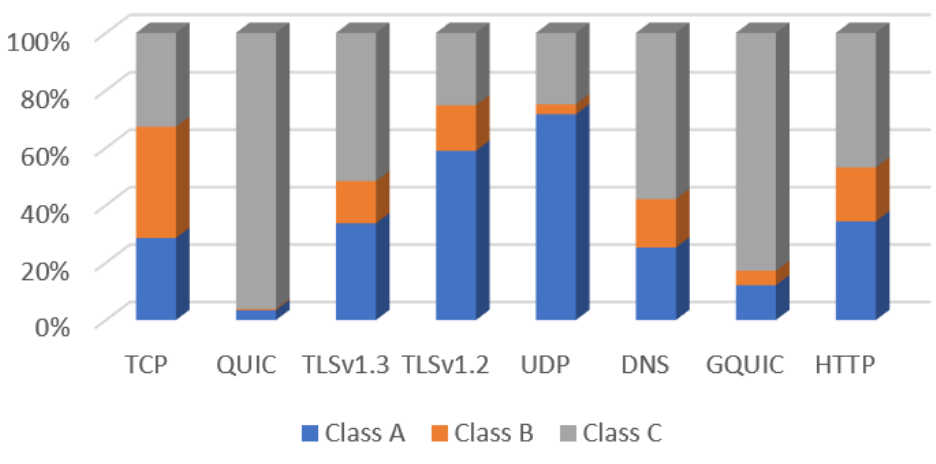
Figure 4. Dataset network traffic protocol distribution.